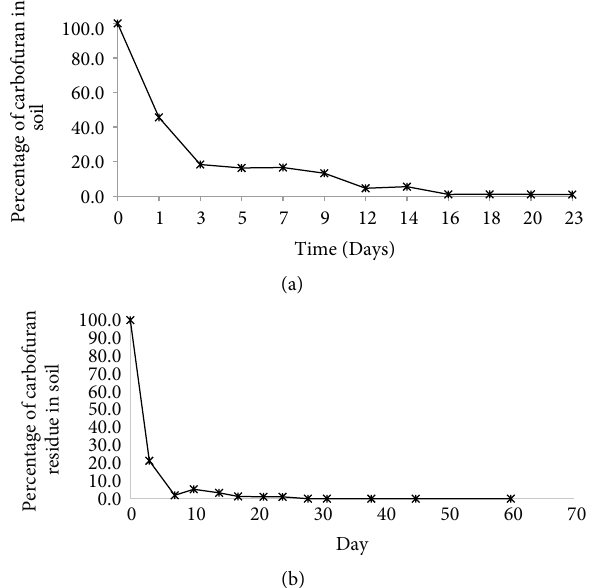
Figure 5: The percentage of carbofuran residue in soil of (a) Chinese kale and (b) brinjal over the experimental period.